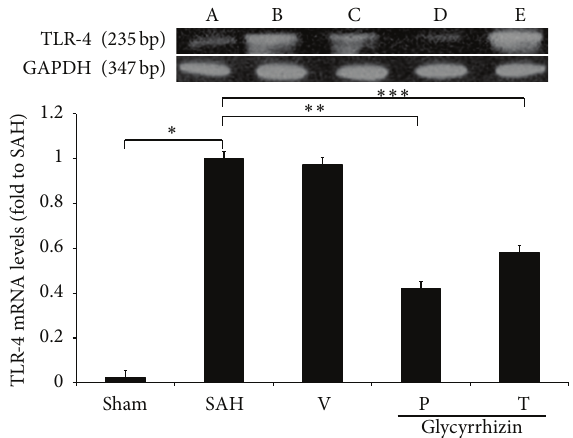
Figure 7: The alteration of TLR-4 mRNA in animals following SAH. All values are mean ± SD ( 𝑛 = 9 ). ∗ , ∗∗ , ∗∗∗ : 𝑃 < 0.01 , when compared with the SAH group. All groups are equal to those publicized in Figure